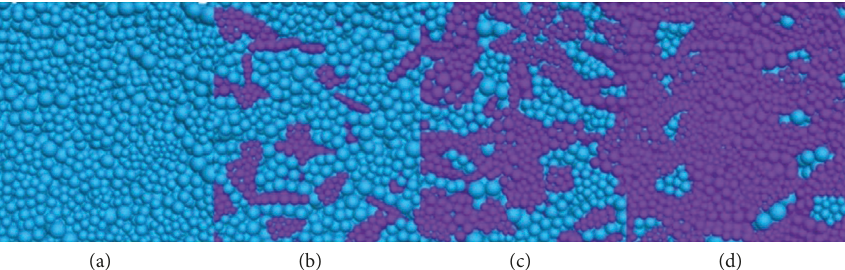
Figure 5: Schematic view of four composite patterns (purple denotes shape-A agglomerates, and royal blue denotes shape-B agglomerates). (a) 0% shape-A. (b) 15% shape-A. (c) 37.5% shape-A. (d) 60%